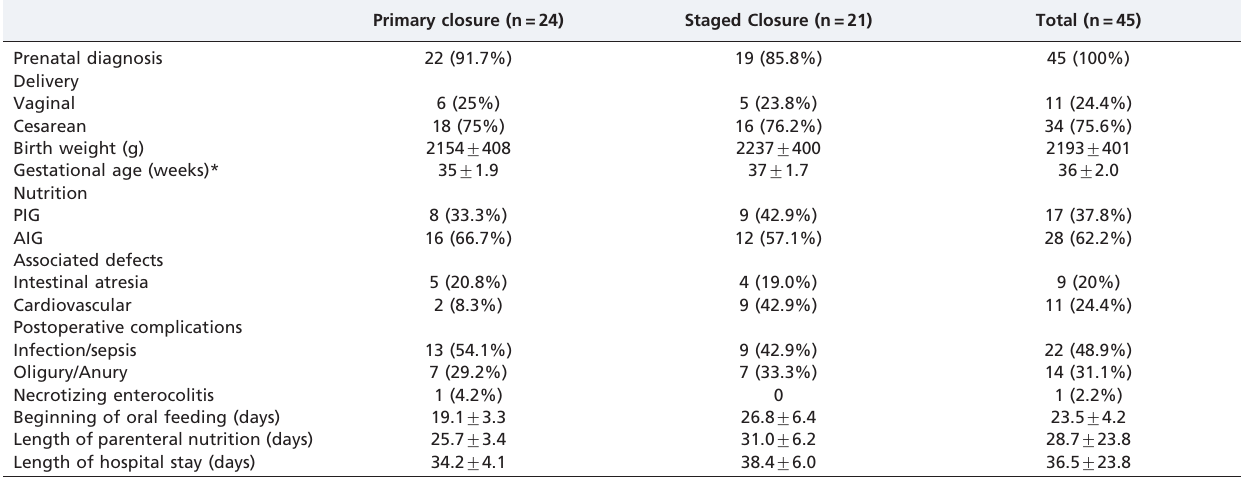
Table 1 - Prenatal and neonatal data for both groups and for all of the newborns included in the study. Newborns in whom primary closure was feasible were born at a significantly lower gestational age (p ,